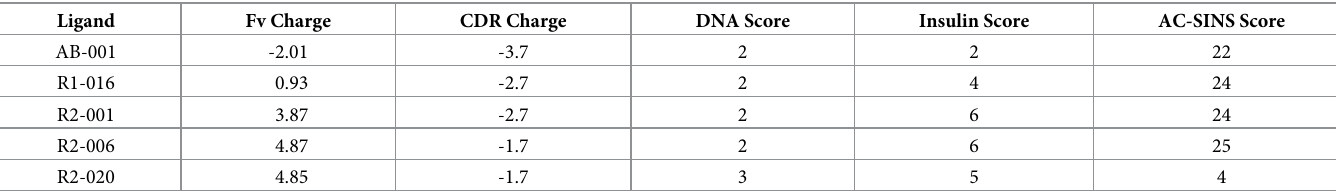
Table 4. FV-charge, CDR-charge and non-specificity properties of top viscosity reducing